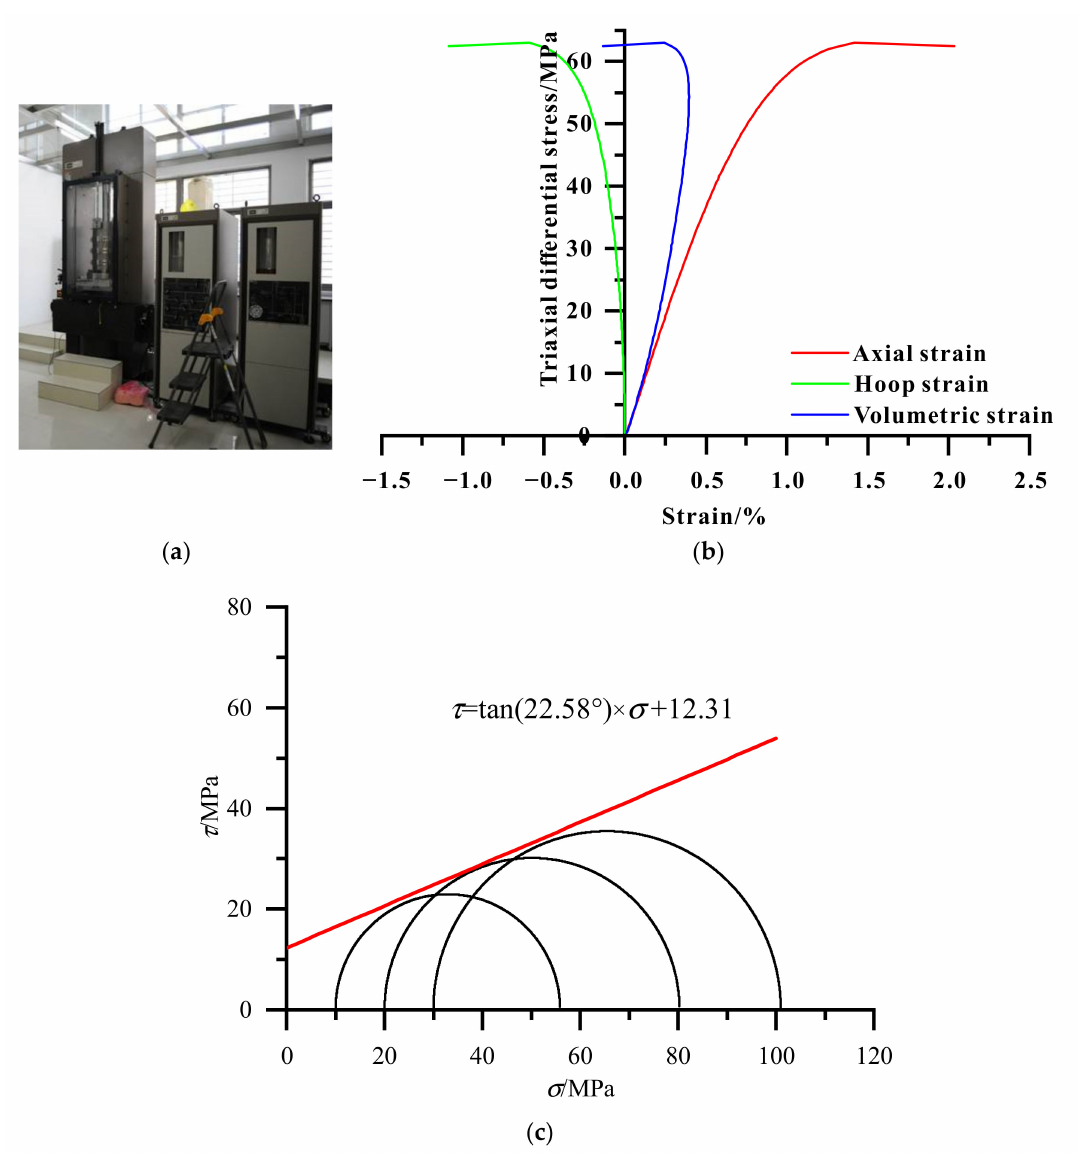
Figure 1. Triaxial compression test on the drilled core from the target formation. ( a ) MTS 815 rock mechanics test system. ( b ) Stress-strain curve and images before and after the test of one core sample in well #1. ( c ) The fitted Mohr circle and the calculation of the friction angle and cohesion strength. The well logging data of #1, #2 and #3 included the CAL, DTC, DTS, GR, NP, RI, RXO, RT and DEN. Then, the mechanical properties of the rock in the corresponding well were calculated using the linearly modified equations of Equations (1)–(3), as shown